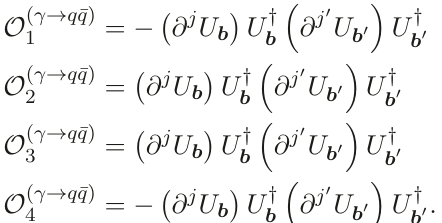
q ¯ q amplitude in an external shockwave background with the appropriate color →